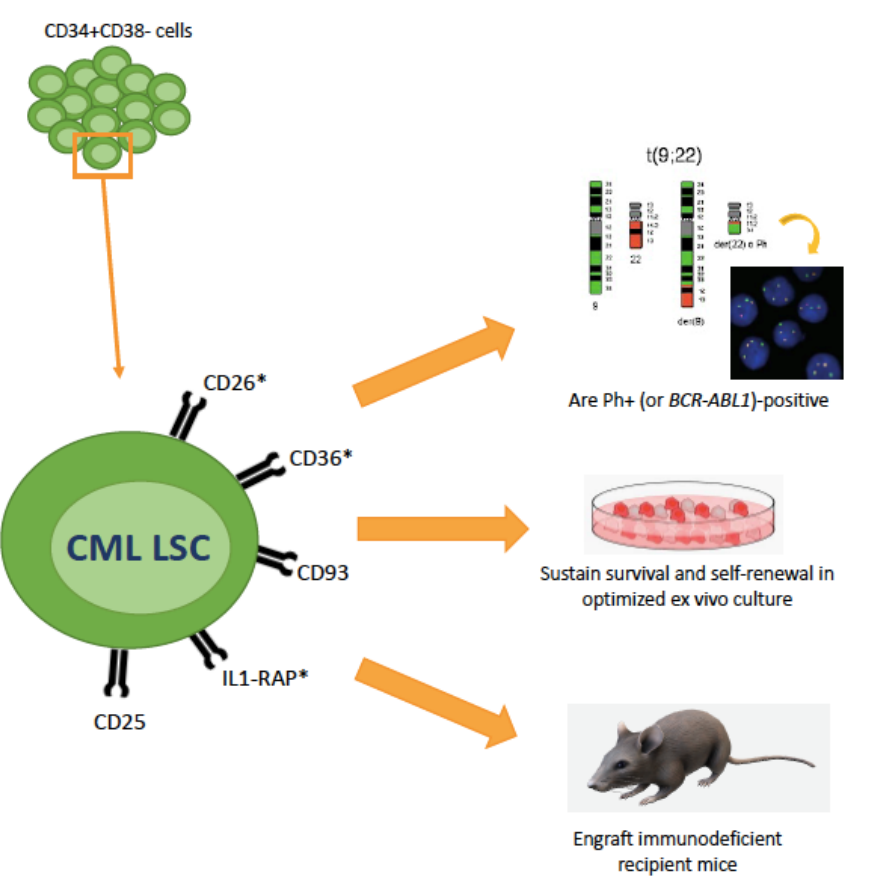
Figure 2. Recent advances in the characterization of CML LSCs markers (and therapeutic targets). CML LSCs lie in the CD34+CD38– cellular fraction but represent only a minority of these cells. Additional surface markers that have recently been identified are shown here. The asterisk denotes whether these markers have also been explored as therapeutic targets. These markers have been shown useful to isolate a population that is BCR-ABL1-positive and functionally behave as LSCs.